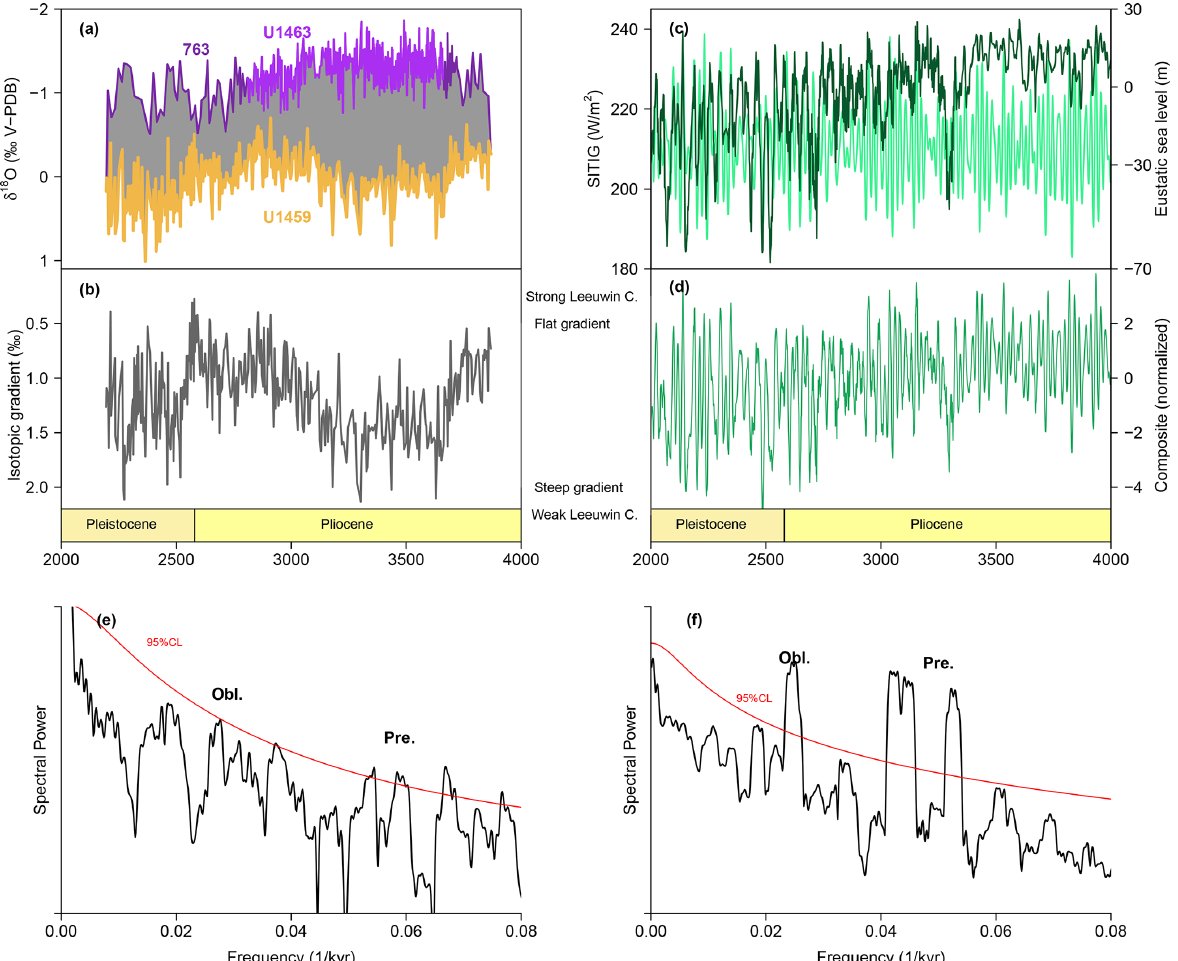
Figure 6. (a) ODP Site 763 and IODP Site U1463 δ 18 O time series from the Northern Carnarvon Basin (purple), compared to IODP Site U1459 δ 18 O time series from the Perth Basin (orange). (b) Isotopic gradient between the Northern Carnarvon Basin (19 ◦ S) and the Perth Basin (29 ◦ S) along the Leeuwin Current pathway. (c–d) Forcing factors that are thought to influence Leeuwin Current intensity include eustatic sea level (dark green; Rohling et al., 2021; using the data in Westerhold et al., 2020) and the summer (21 June) intertropical insolation gradient (SITIG). They are combined with equal weights in a composite record after normalizing. (e–f) Multi-taper method power spectrum (Thomson, 1982) of the isotopic gradient and forcing composite. Their spectral signature is similar, dominated by obliquity and precession, and without a strong 100kyr imprint. Spectral peaks in panel (e) are not strongly expressed because the underlying records have been subject to conservative astronomical tuning and age–depth